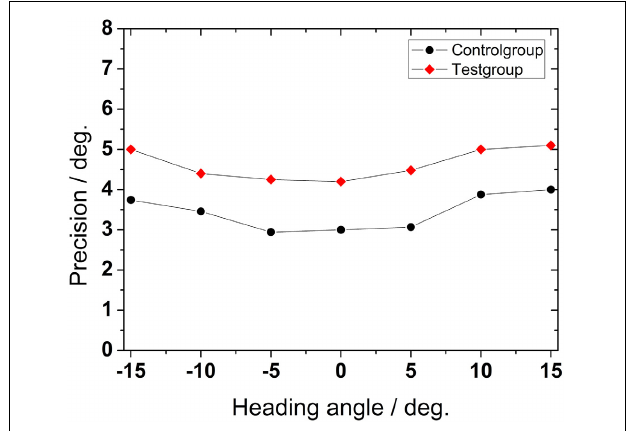
FIGURE 5 | Precision of heading detection. Data show the standard deviation of the mean perceived heading directions as function of the presented heading direction, averaged across presentation time and number of dots for all subjects.